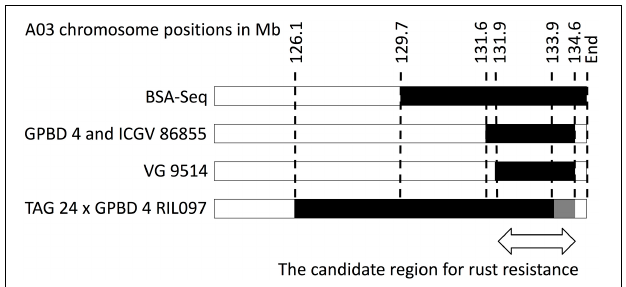
FIGURE 3 | Graphical genotypes of A03 for resistant lines. Black bars show chromosome segments derived from the resistant donor, GPBD 4. Numbers on the top are chromosome positions in a mega-base scale. An arrow indicates an overlapping region of the GPDB 4 genome corresponding to the candidate region for rust